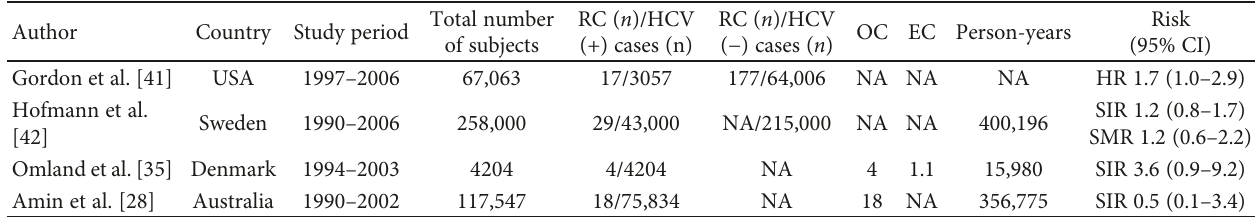
Table 6: Cohort studies for association of chronic HCV infection with renal cancer